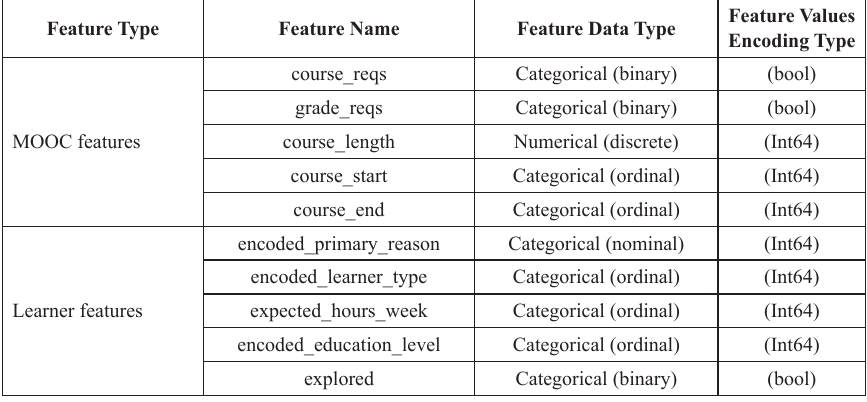
Table 1. Features ‘selection for learner motivation prediction for a